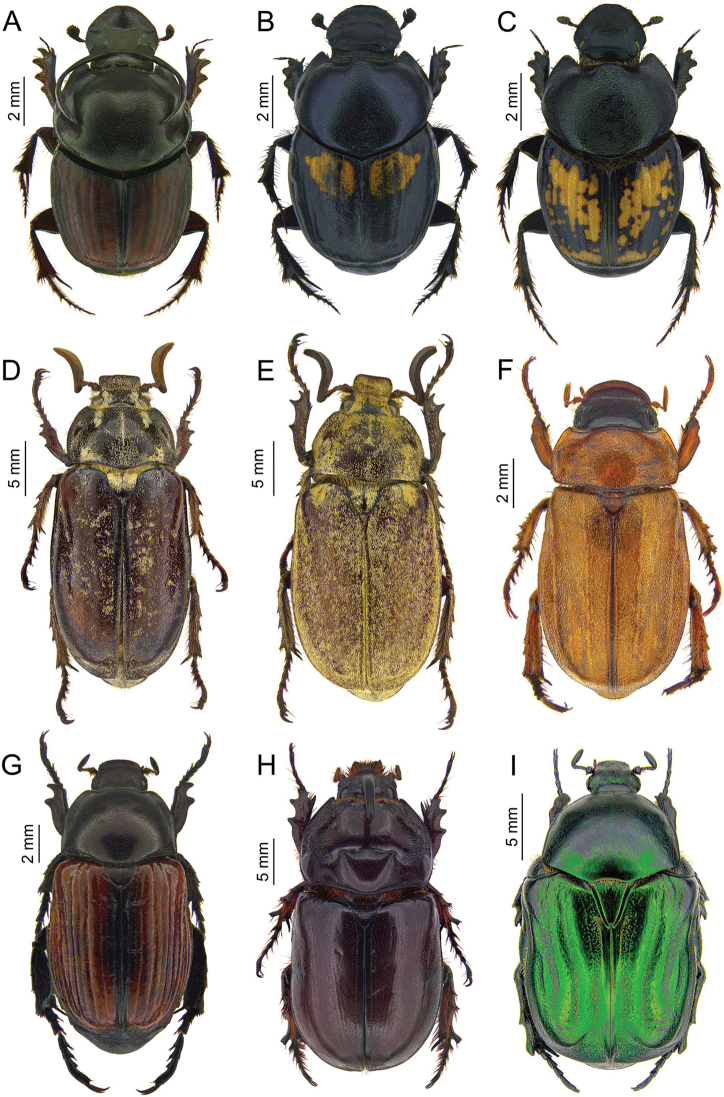
Photos of Scarabaeidae specimens collected during the expedition to Tajikistan in 2014 AOnthophagus
taurus, male BOnthophagus
basipustulatus, female COnthophagus
pygargus, female DPolyphylla
tridentataEPolyphylla
adspersaFAdoretus
nigrifronsGCyriopertha
glabraHOryctes
nasicornis
turcestanicusIProtaetia
bogdanoffi.